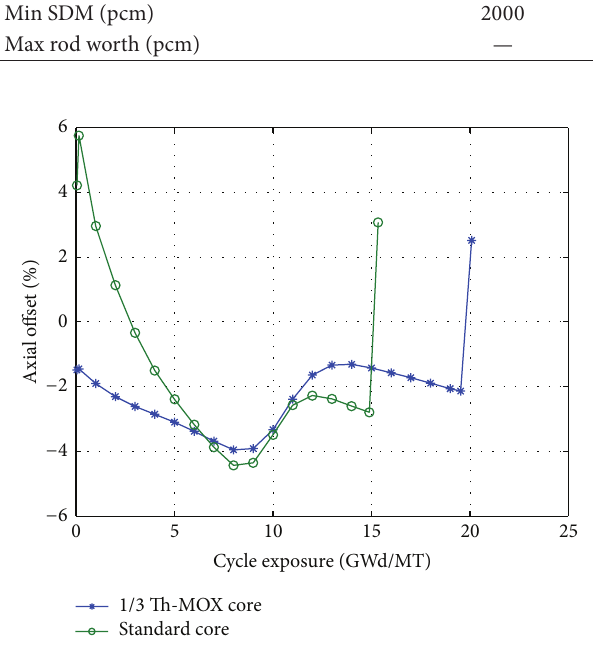
Figure 7: The axial offset as function of burnup for the standard and 1/3 Th-MOX core.